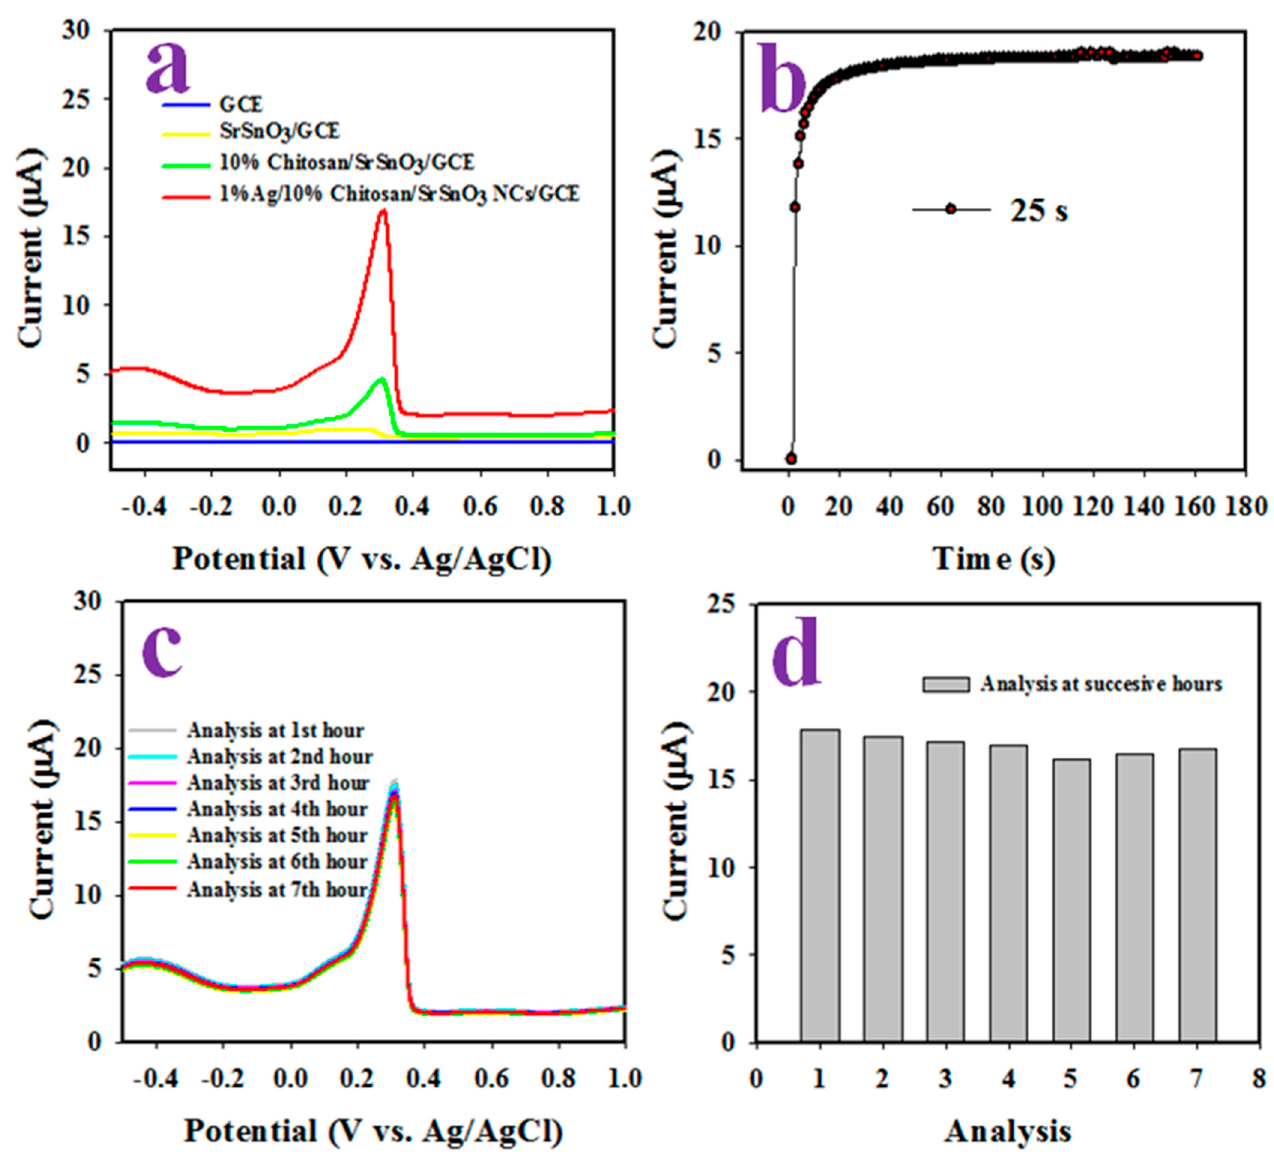
Figure 9. Analysis of sensor performance with Ag-decorated Chitosan/SrSnO 3 NC/GCE. ( a ) Control experiment in DPV analysis of 2,6-DNP, ( b ) Response time at current versus time, ( c ) Reproducibility of 2,6-DNP sensor, and ( d ) Reproducibility bar diagram.